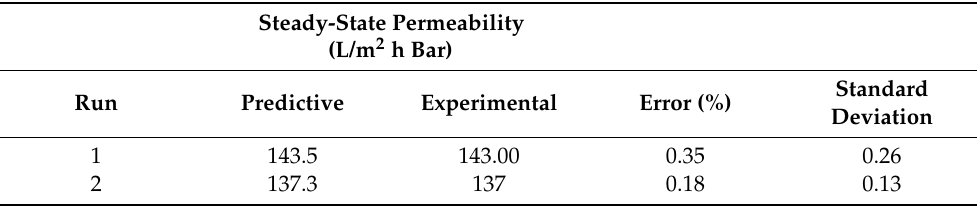
Table 6. Permeability response function for the experimental and model